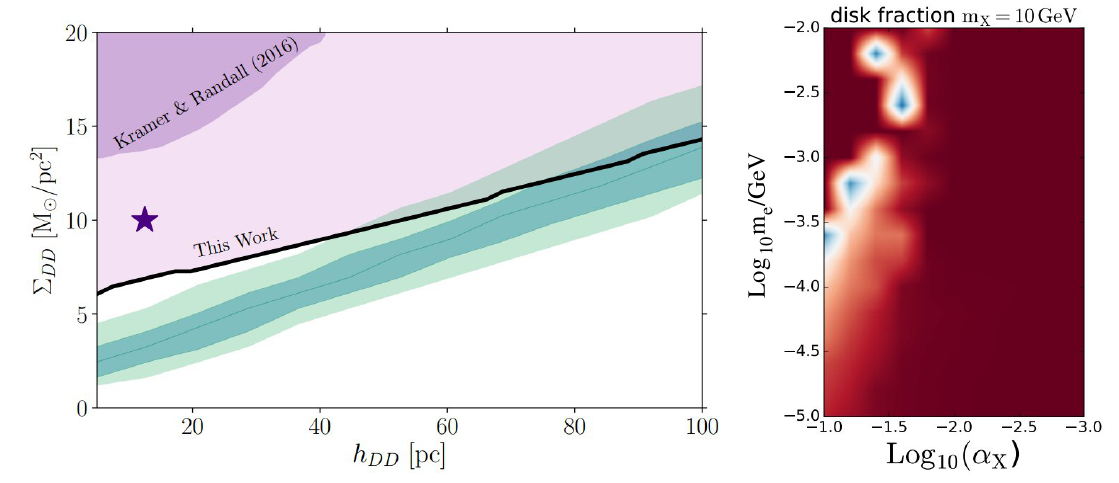
Figure 7: Left: constraints on a dark disk surface density Σ from Ref. [ 49 ] . The star denotes parameters preferred by Ref. [ 50 ] for explaining possibly enhanced periodic comet impacts on Earth. Right: regions (blue / white) of m versus α (cid:48) where a dark disk forms, for m e (cid:48)